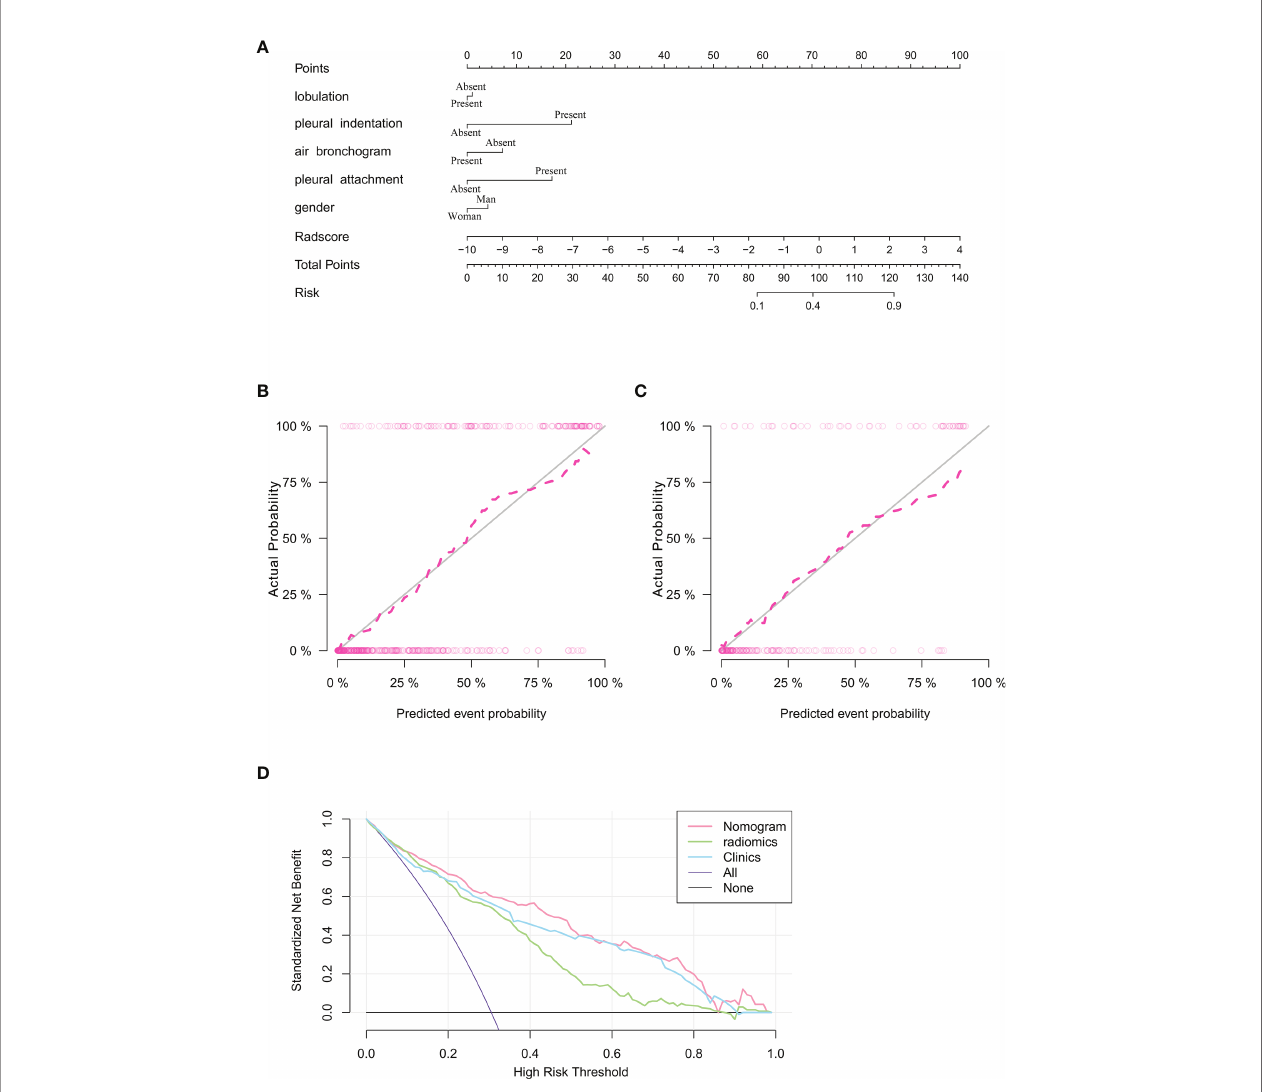
FIGURE 5 | Nomogram for prediction of VPI based on training cohort and the model evaluation of calibration curve. (A) Radiomics nomogram based on clinical characteristics and Radscore. The calibration curves were used to evaluate the consistency of the probability of VPI predicted by the nomogram with the actual fraction of visceral pleural invasion in the training (B) and validation (C) cohorts. (D) DCA for the prediction of VPI in lung adenocarcinoma for each model. X-axis represents the threshold probability and Y-axis represents the net bene fi t. The red curve represents the nomogram. The blue curve represents the clinical features model. The green curve represents the radiomics features